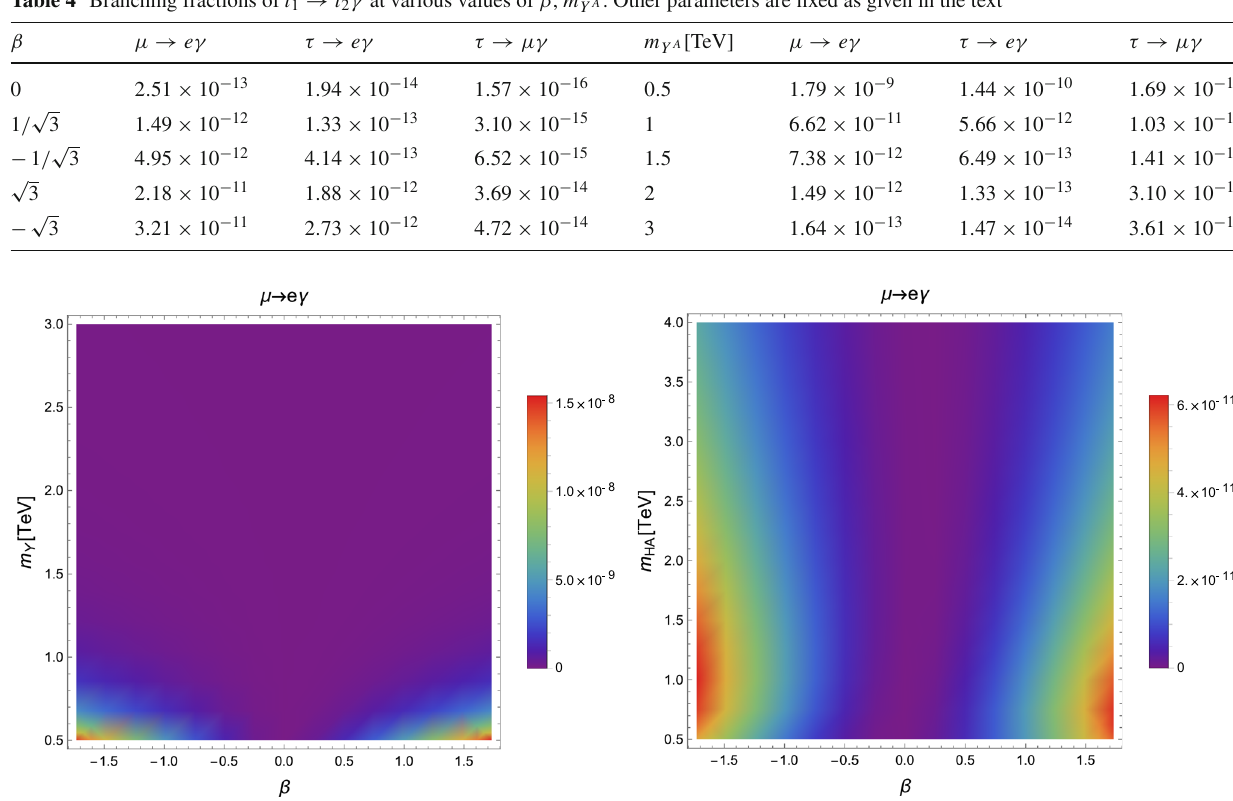
Fig. 3 Density plot of μ → e γ branching fraction as a function of β and m Y (left) and of β and m H A (right). Other parameters are fixed as given in the